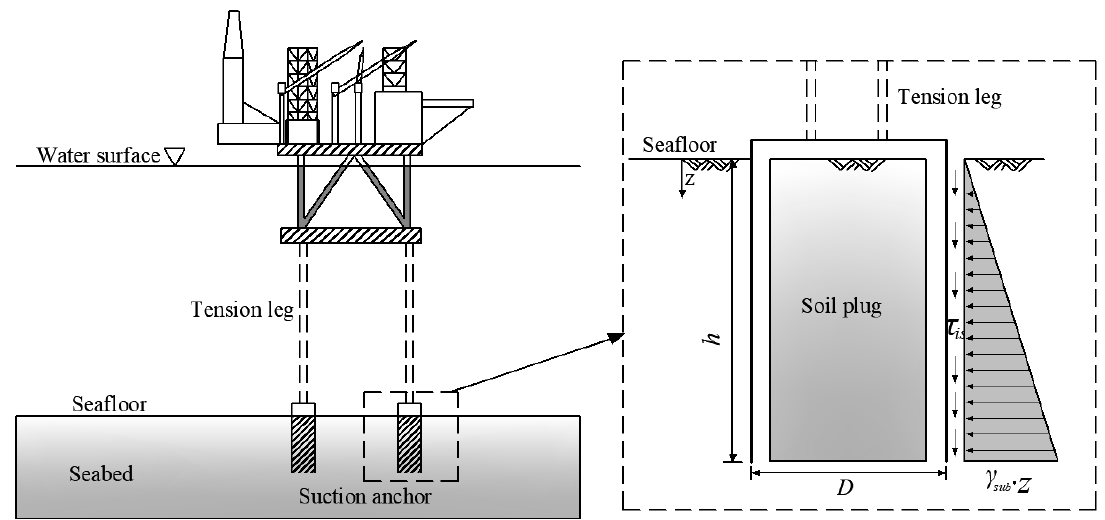
Figure 1. Schematic view of a platform anchored to suction caissons at the seabed.